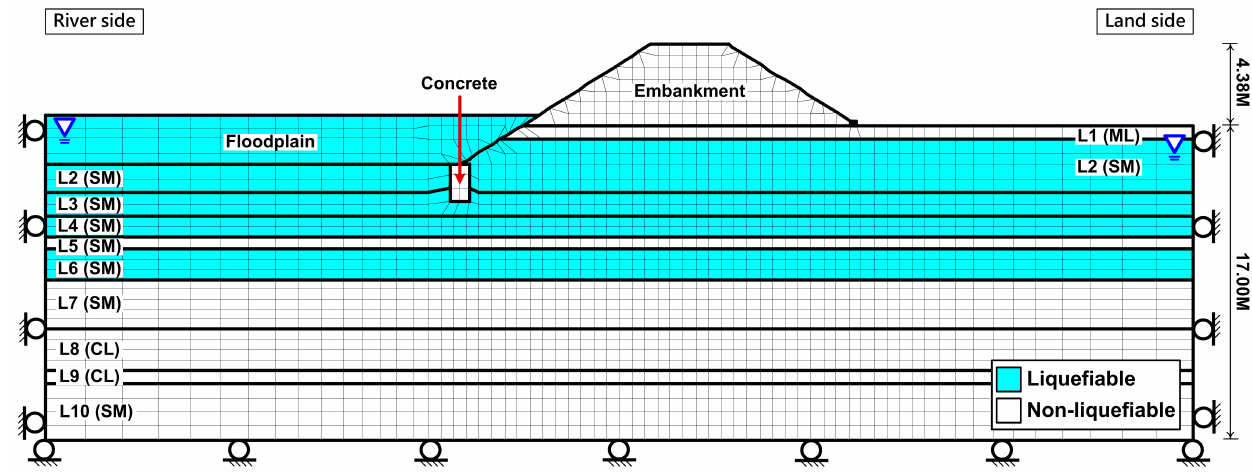
Figure 14. The numerical model of the embankment. Table 6. The soil parameters of the numerical